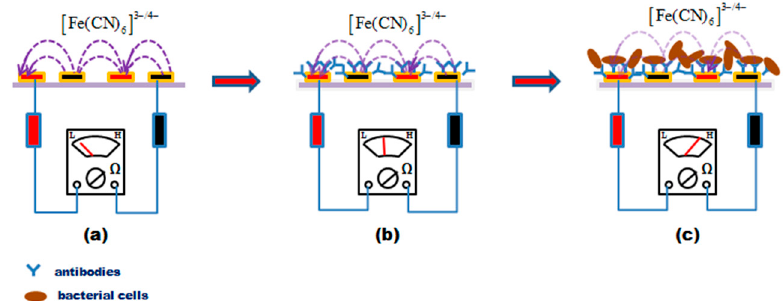
Figure 1. Principle of the immunosensor: ( a ) bare IDAM; ( b ) IDAM with antibody immobilization; and ( c ) IDAM with bind bacterial cells.